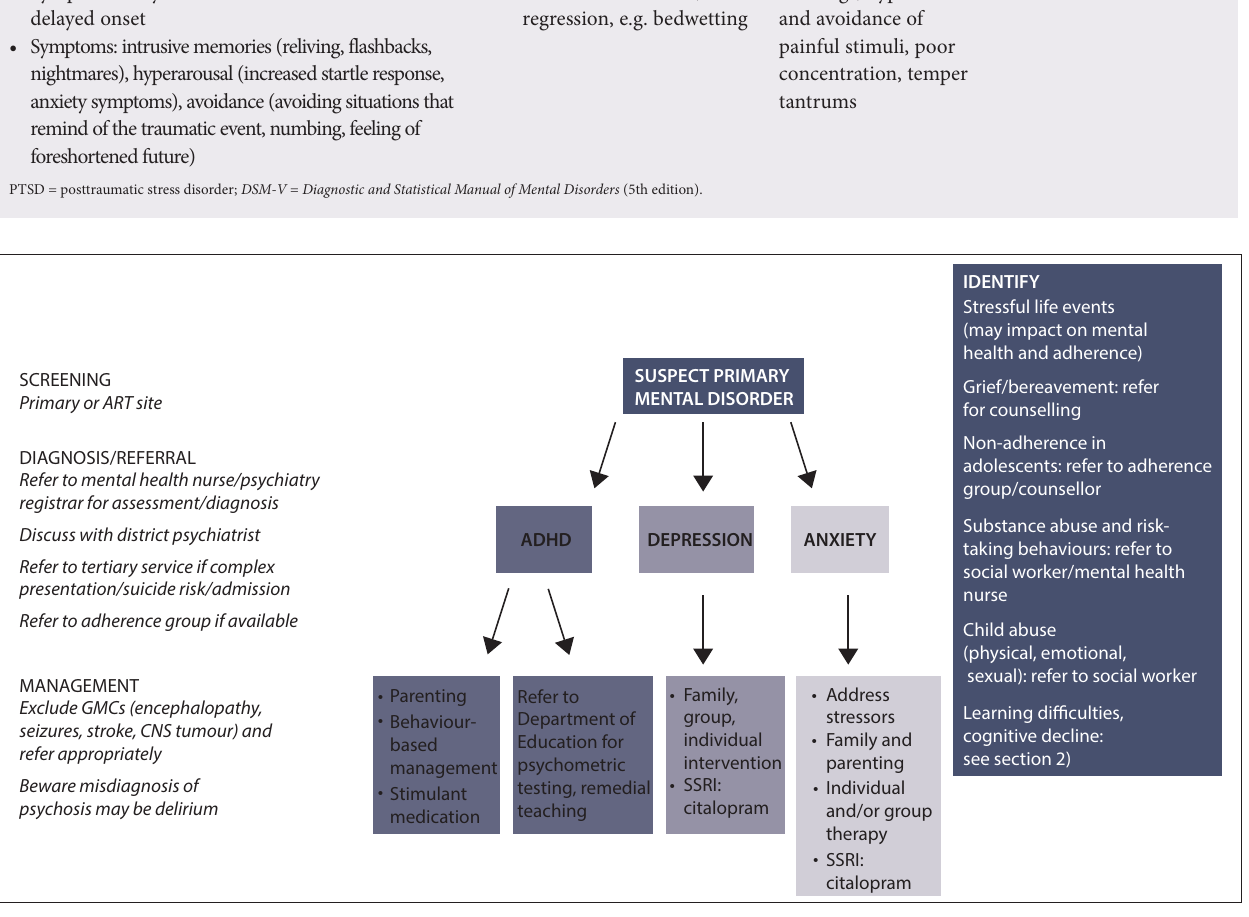
Fig. 1. Recognising primary mental disorders in HIV-positive children and adolescents. (ART = antiretroviral therapy; ADHD = attention defi cit hyperactivity disorder; GMCs = general medical conditions; CNS = central nervous system; SSRI = selective serotonin re-uptake inhibitor.)